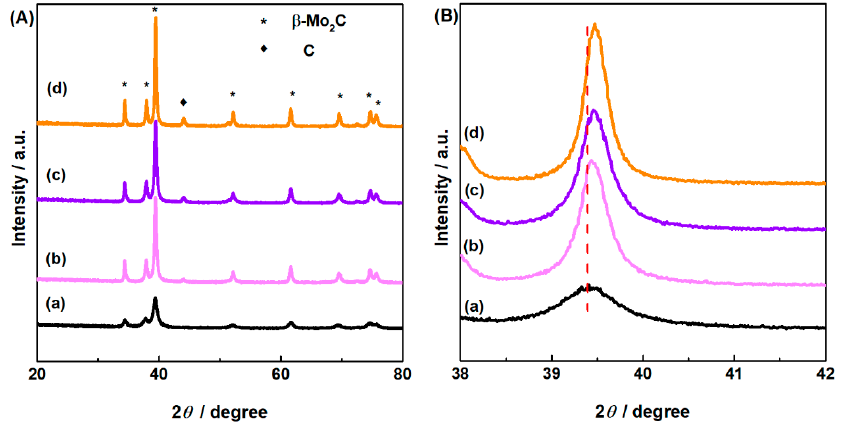
Figure 1. XRD patterns of (a) MC, (b) MC-Ni-1, (c) MC-Ni-1.5 and (d) MC-Ni-2 in the 2 θ range of ( A ) 20–80° and ( B ) 38–42°. Table 1. Physical properties of the catalysts.